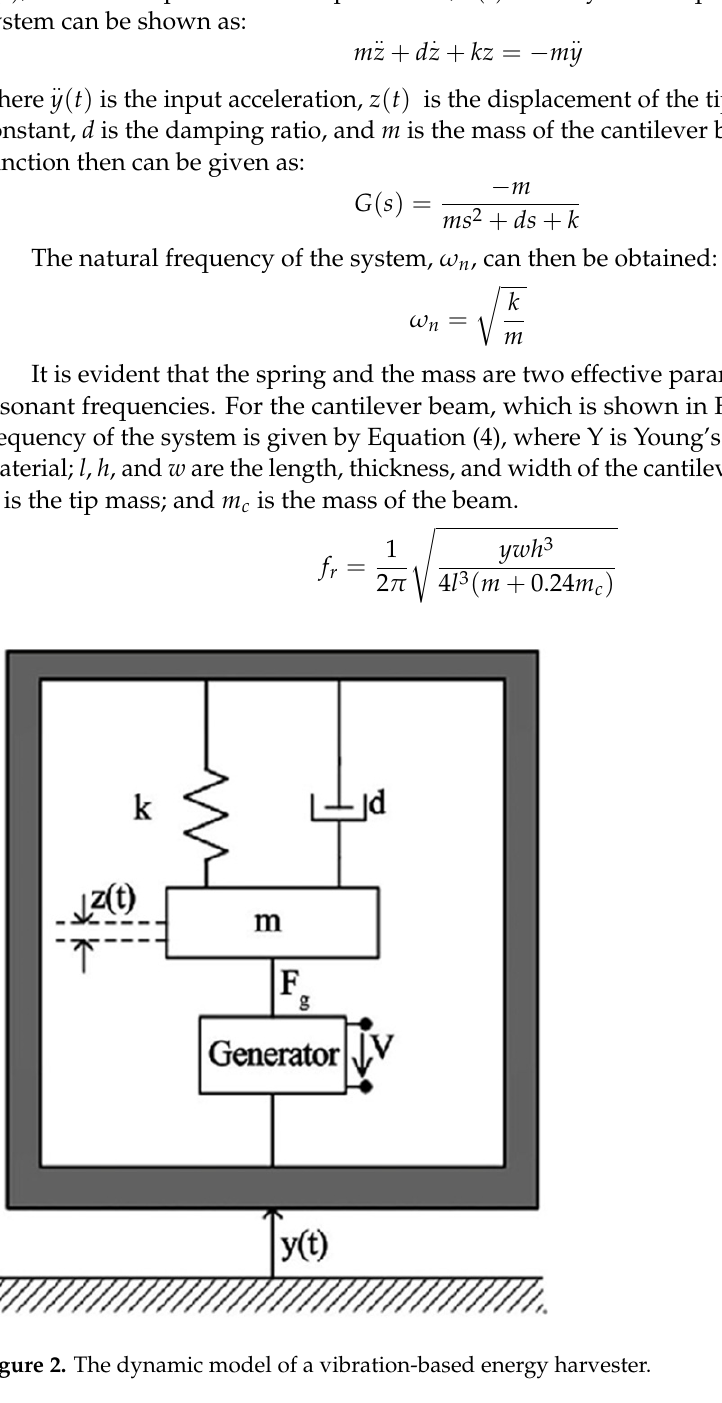
current operating frequency of the